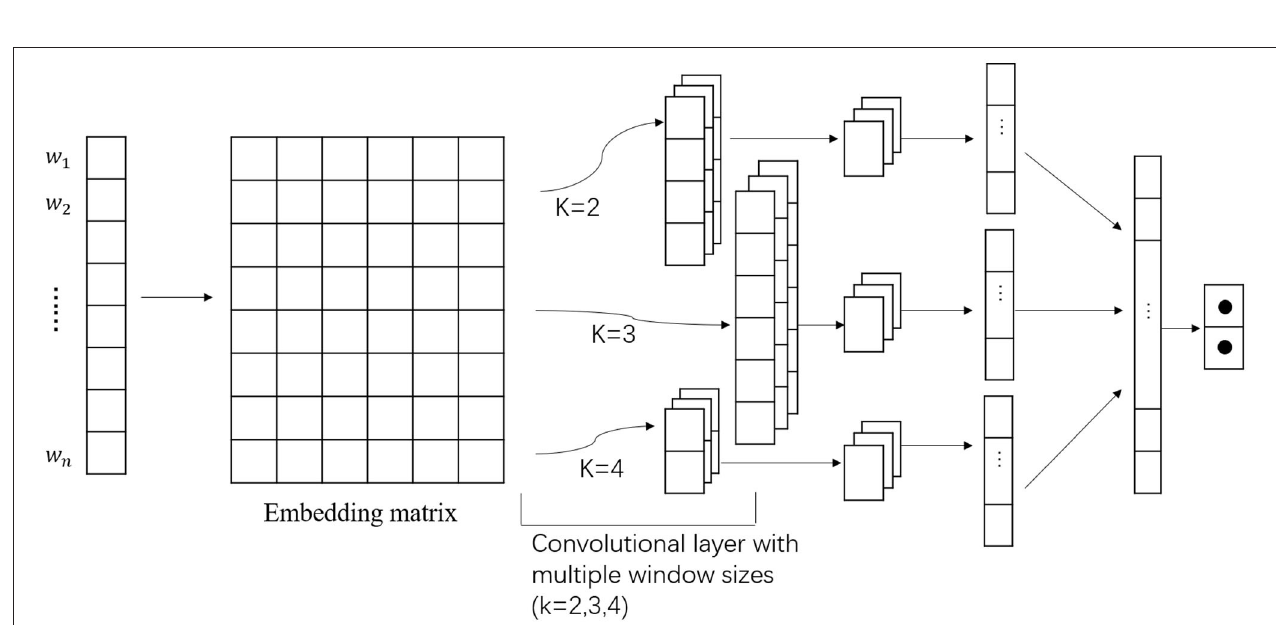
FIGURE 2 | The architecture of MoLeSy.